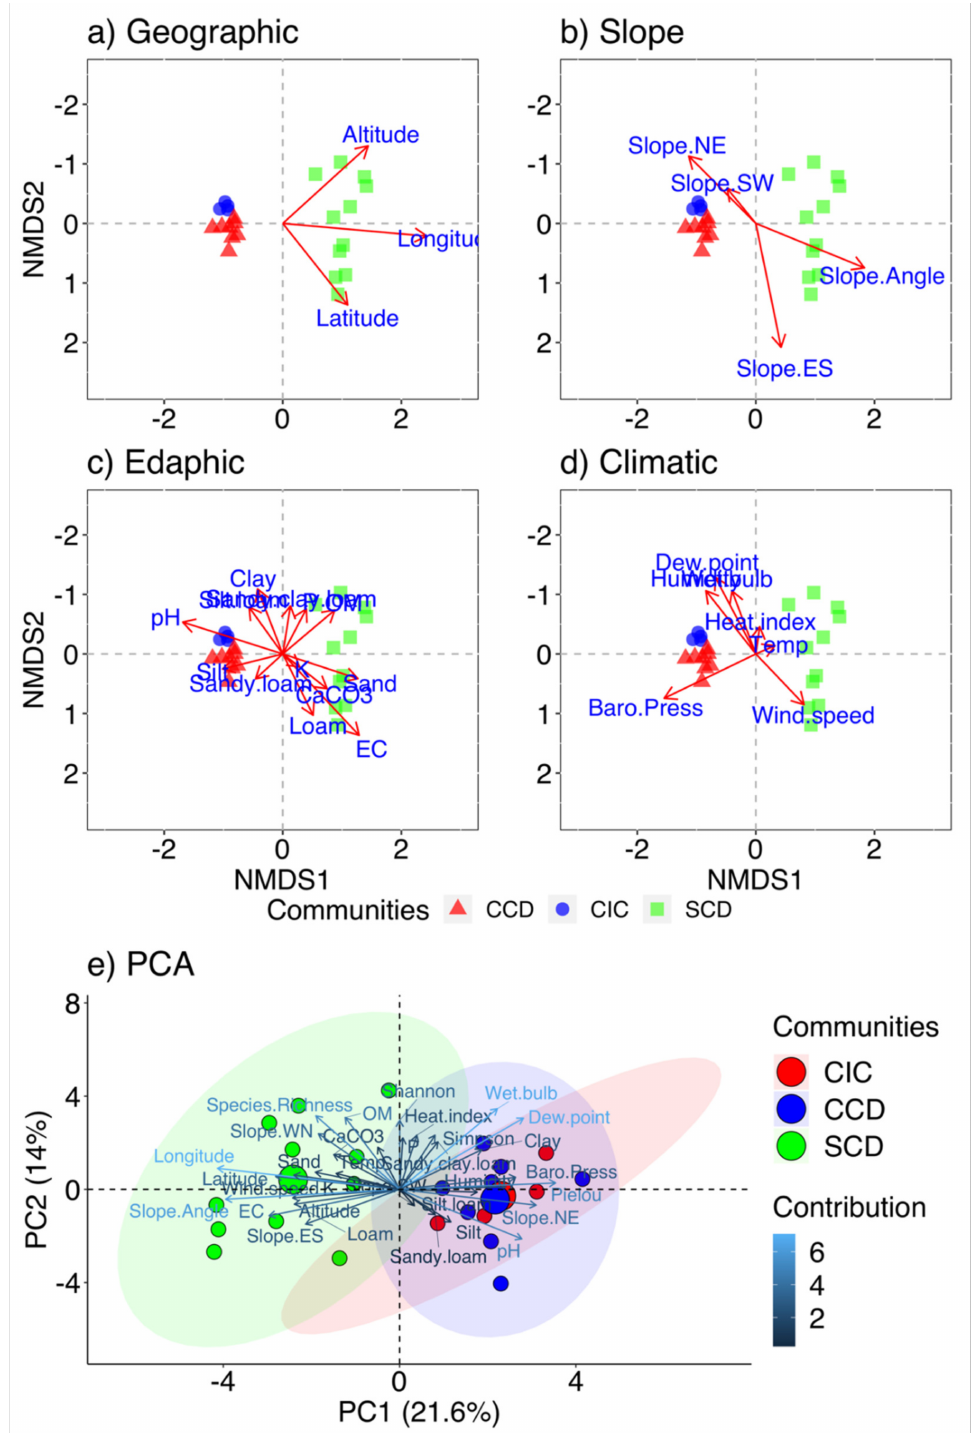
Figure 4. Multivariate analyses among plant communities of pure Deodar forest and environmental variables. ( a – d ) Non-Multidimensional Scaling (NMDS) of three plant communities and their ecologi- cal variables such as geographic ( a ), slope ( b ), edaphic ( c ), and climatic ( d ). ( e ) Principal Component Analysis (PCA) ordination of three communities along the environmental variables. For the complete names of plant communities, see Figure